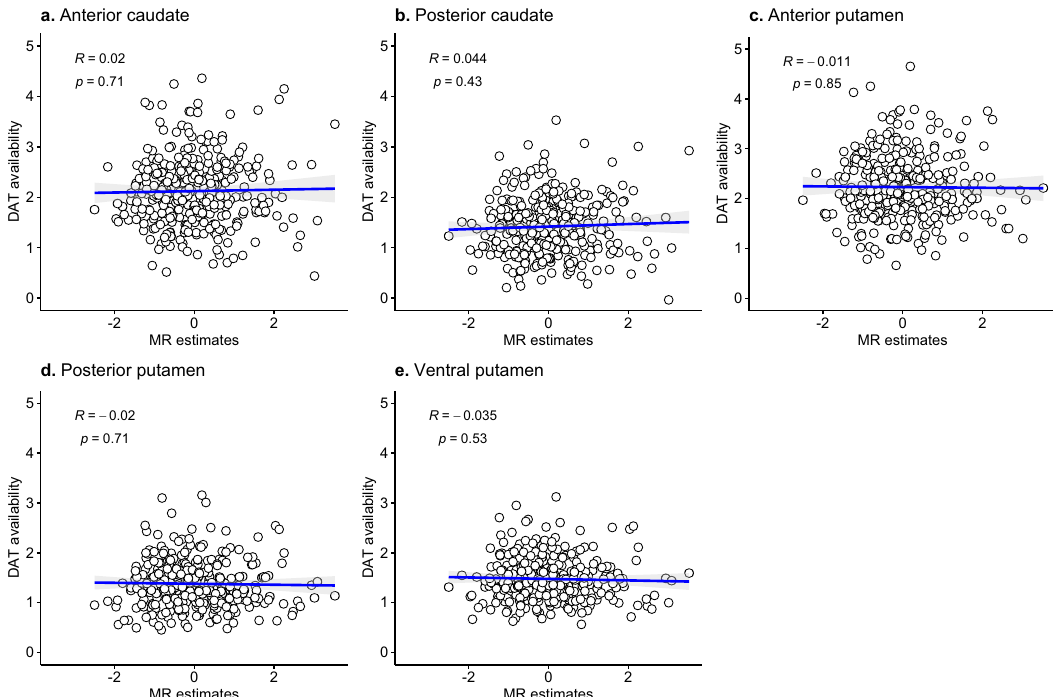
Fig. 2 Correlation analysis between DAT availability and MR estimates. a – e DAT availability in each striatal subregion was not associated with MR